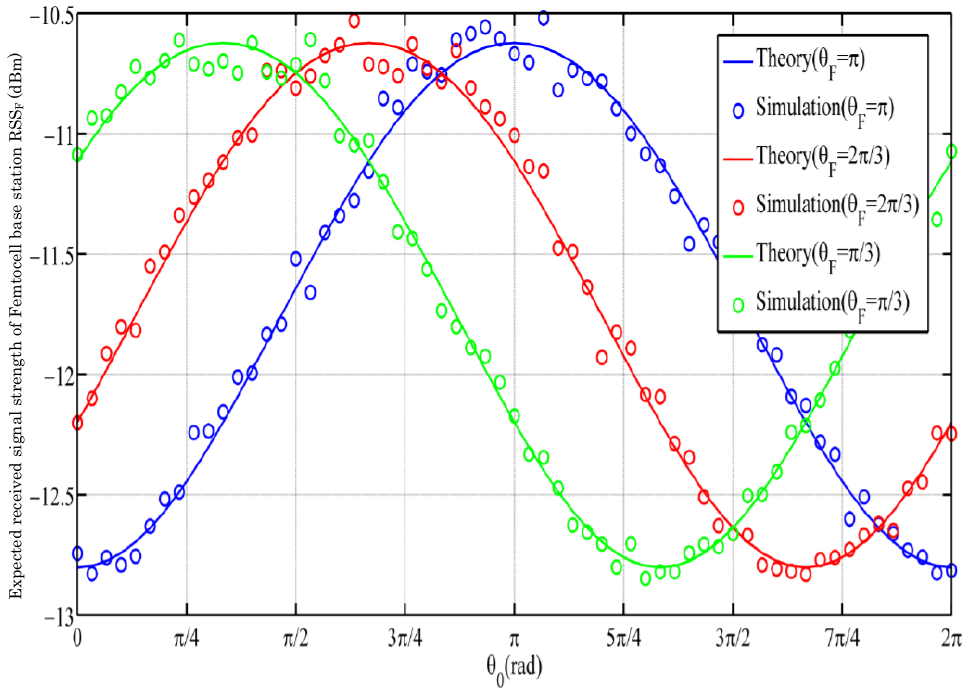
Figure 14. When r = 30 m/s, expected received signal strength of femtocell base station RSS F .